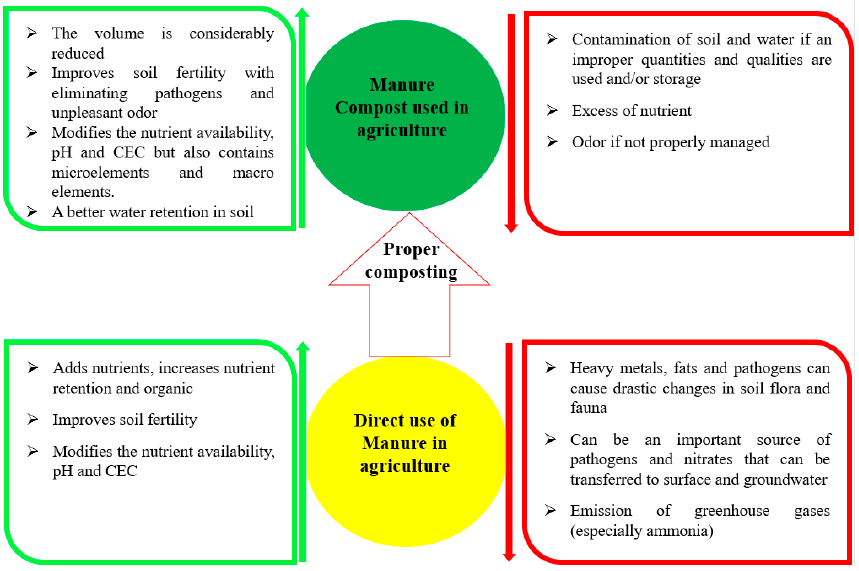
Figure 1. Some aspects related to the use of manure and manure compost used as soil amendment.